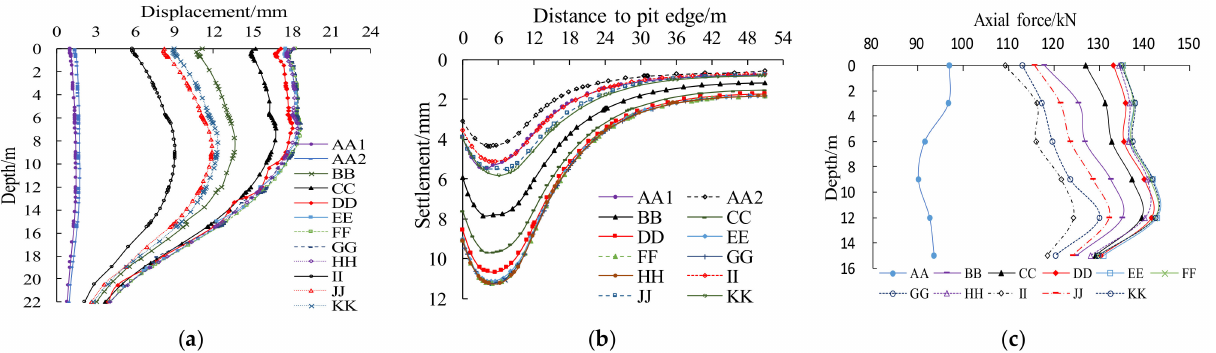
Figure 17. Simulation results of different sections: ( a ) Horizontal displacement of piles, ( b ) Ground settlement, ( c ) Axial